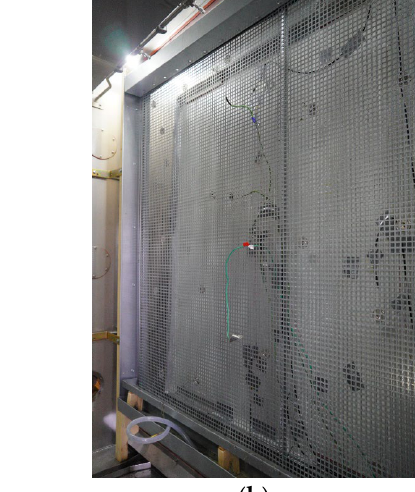
( c ) Figure 3. Scheme of the tested façade sample: ( a ) IMP-only setup, ( b ) VB setup, and ( c ) vegetation adopted to the upward orientation after vertical placement of the board, visible thermocouple cable for S1 position, bottom drainage gutter, and water tank. 2.2. Boundary Conditions The simulated day was based on the real measured values by the department’s weather station on the site used for other experimental measurements [28]. A sunny sum- mer day was chosen, with the night temperature close to 20 °C to avoid the possibility of night cooling and a daily maximum near 37 °C. In the indoor chamber, 20 °C was set up